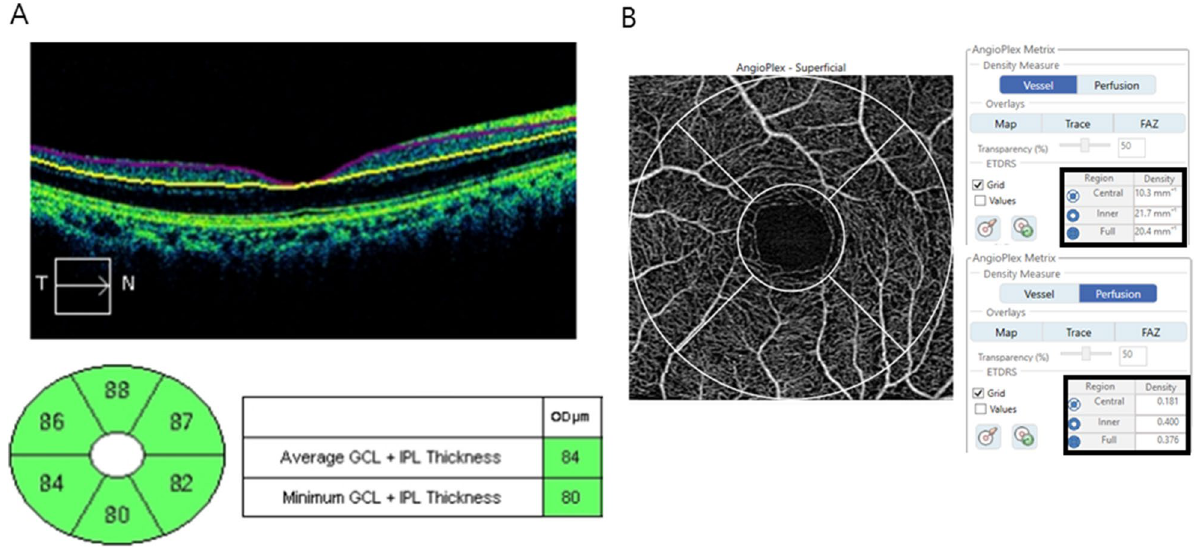
Figure 1. The thickness of the ganglion cell-inner plexiform layer (GC-IPL) using spectral-domain optical coherence tomography ( A ) and parameters of microvasculature using optical coherence tomography angiography ( B